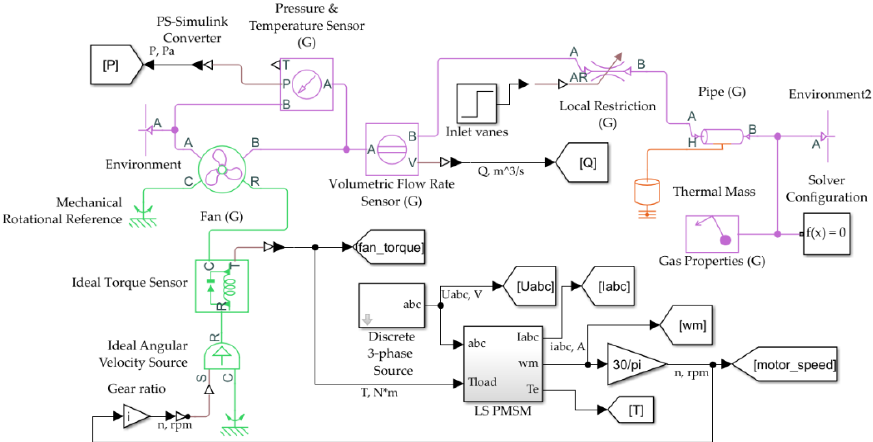
Figure 5. General view of the model of the fan with the LSPMSM drive in the Matlab Simulink. The Fan (G) block connects the hydraulic and mechanical models. Ports A and B are connected to the hydraulic circuit (purple lines), and ports C and R are connected to the mechanical circuit (green lines). The hydraulic circuit variables are the flow and pressure.